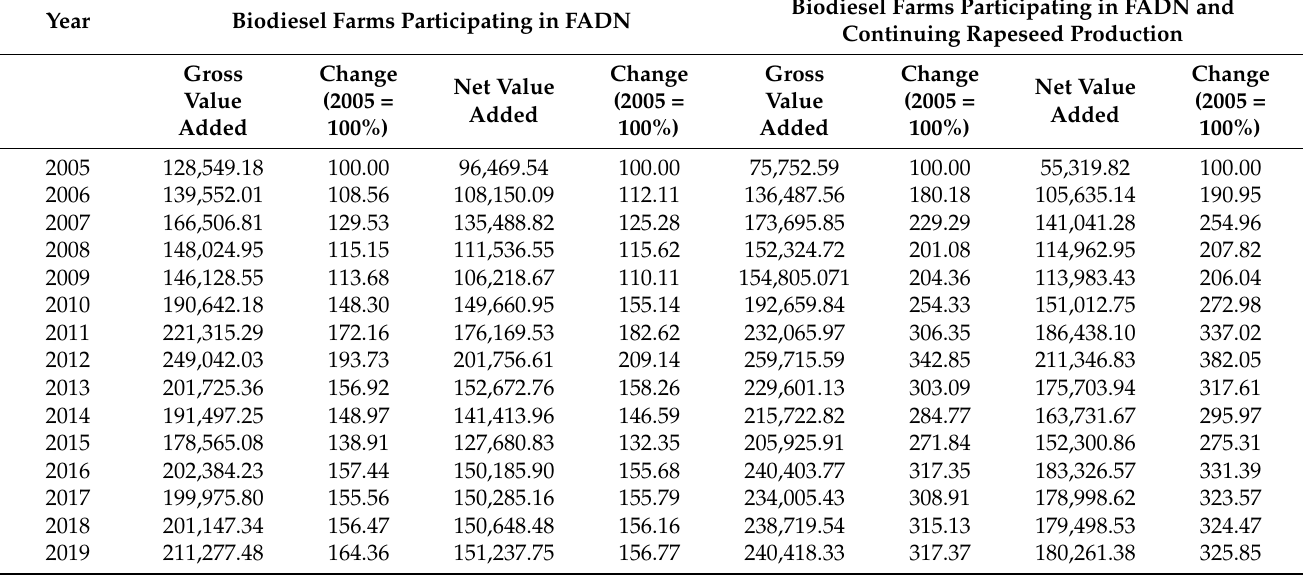
Table 7. Gross value added and net value added per Polish biodiesel farm from 2005 to 2019 (PLN).